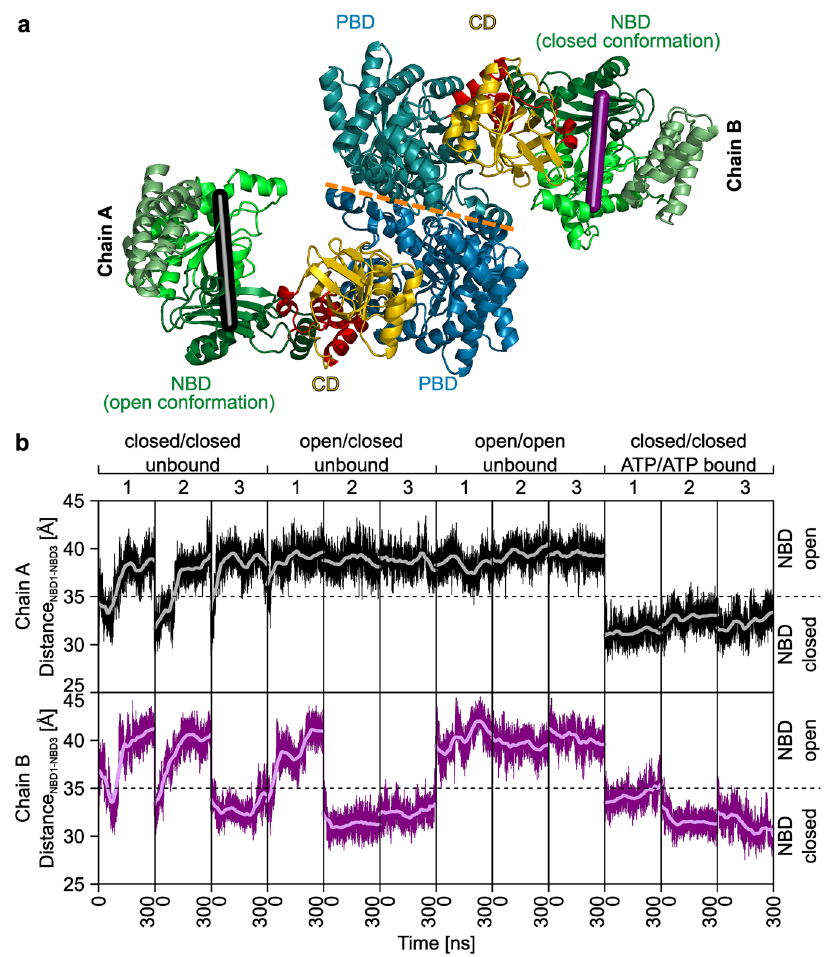
Figure 1. Unrestrained MD simulations of dimeric PPDK. ( a ) Crystal structure PDB ID 5JVJ showing two monomers (chains A, B) of PPDK in the asymmetric unit. The central domain (CD, yellow) contains the catalytic histidine. At the nucleotide-binding domain (NBD, with the three subdomains depicted by three different greens) and the PEP/pyruvate-binding domain (PBD, colored blue), partial reactions (1) and (2) (see Introduction section) take place. The linker domains (LD, colored red) connect CD, PBD, and NBD. The dimer interface (indicated by the dashed orange line) is formed by the PBDs of both monomers. The NBDs of chain A and B show open and closed conformations, respectively. The distance NBD1-NBD3 measured between S215 C α – E272 C α is used as reaction coordinate for the opening-closing motion of chain A (black line) and chain B (deep purple line). ( b ) Time course of the opening-closing motions of the NBDs of chain A (black line) and chain B (deep purple line) measured by the respective distance NBD1-NBD3 . From the conformations labeled on the top axis, three replica MD simulations each were started of 300 ns length, with the mean over an interval of 60 ns shown in gray (for chain A) and light magenta (for chain